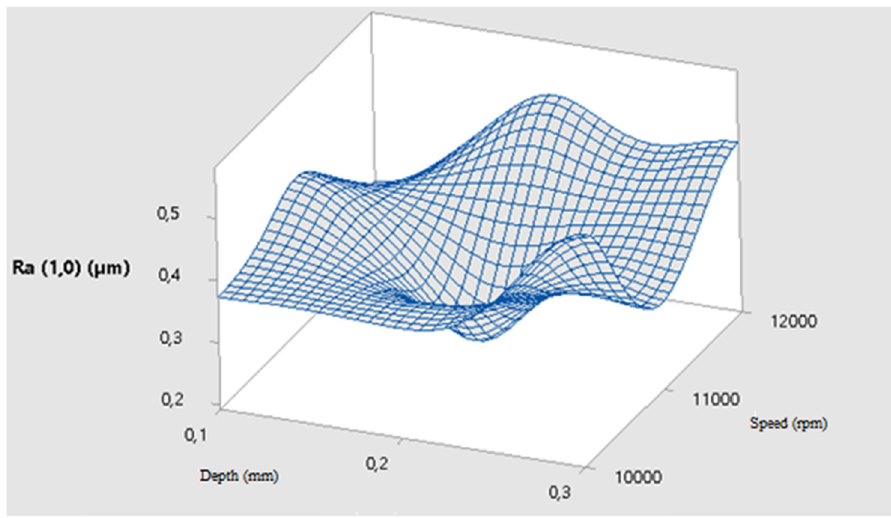
Figure 8: E ff ects of depth of cut and rev on surface